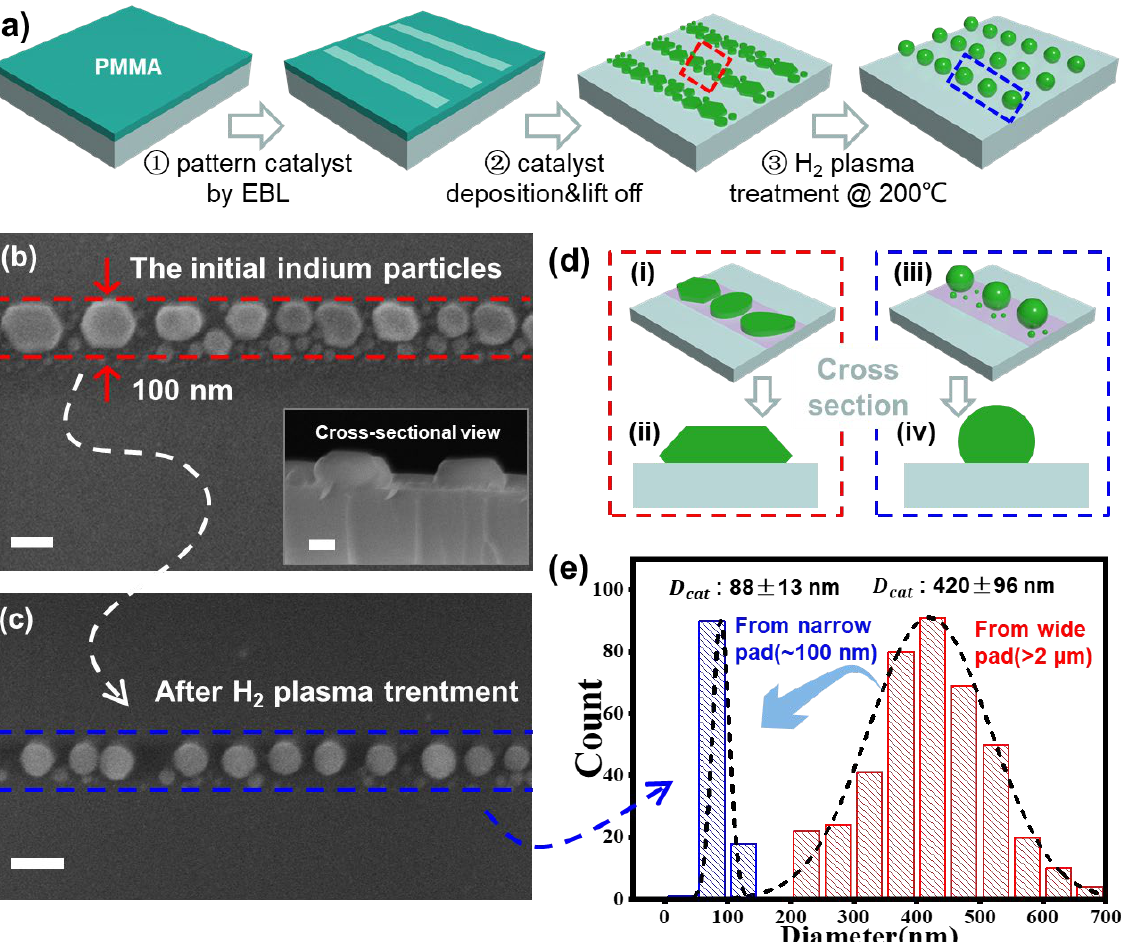
Figure 2. ( a ) Schematic illustration of the formation of uniform In droplets from narrow In stripes prepared by using EBL. ( b ) The SEM image of the initial discrete In catalyst grains evaporated on the nanostripe region with a width of 100 nm, while the inset shows the cross-sectional view of these pancake-shaped catalyst grains. ( c ) The formation of a chain of uniform In droplets after H 2 plasma treatment. ( d ) Tilted and cross-sectional view diagrams of the In grains evaporated (i, ii) and after H 2 plasma treatment (iii, iv) within the nanostripe regions. ( e ) Statistics of the droplet diameters formed within a strong nanostripe confinement (light blue, for narrow W str = 100 nm) or on a much wider In stripe (light red, with W str > 2 μm). Scale bars in ( b , c ) stand for 100 nm.